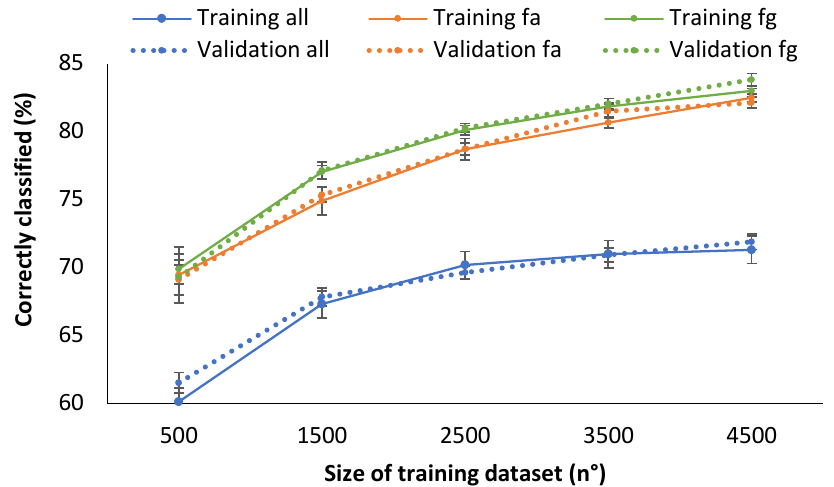
Figure 10. Summary of correctly classified data and the different sizes of training datasets when the different combinations of variables are used. Table 1. Confusion matrix for training dataset when velocity, geo-information, time, fgx, fgy, and fgz are included.